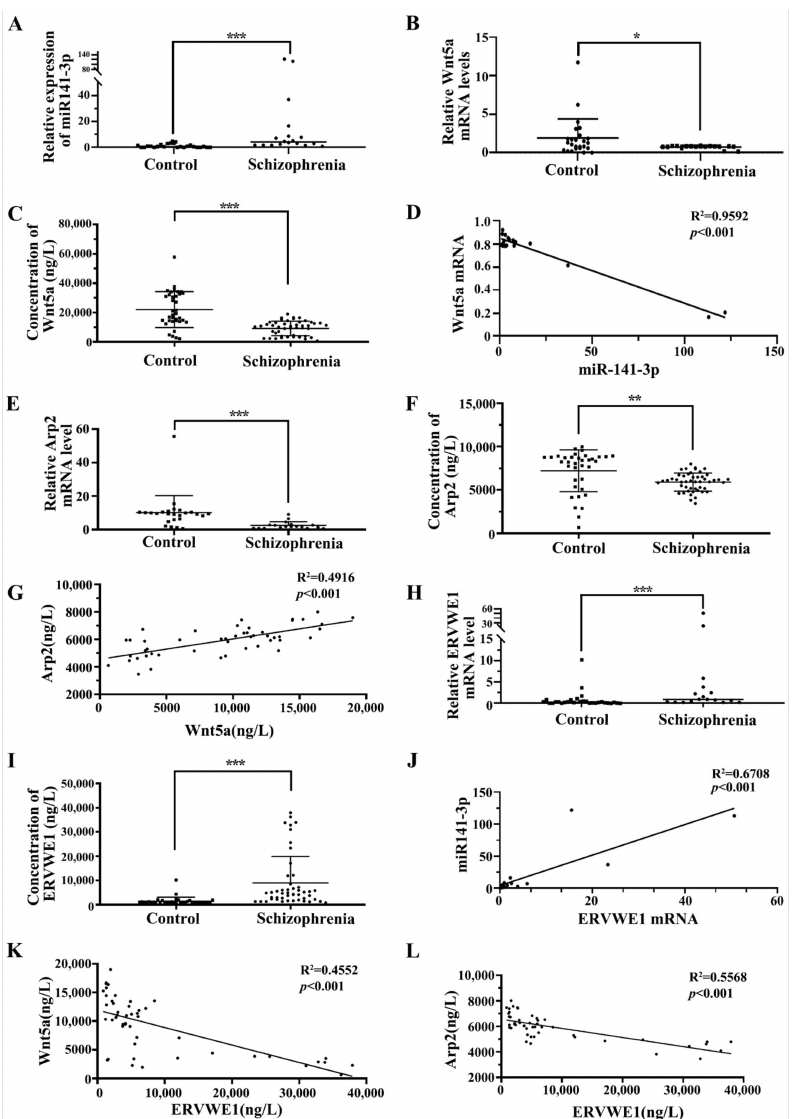
Figure 1. The correlation among miR-141-3p, Wnt5a, Arp2, and ERVWE1 in schizophrenia patients. ( A ) The miR-141-3p level in schizophrenia patients (n = 18) was higher than that in control groups (n = 25). ( B , E , H ) Respectively represent the mRNA levels of Wnt5a, Arp2, and ERVWE1 in schizophre- nia patients (n = 18) and the control groups (n = 25) using RT-qPCR. ( C , F , I ) Respectively represent the protein expression of Wnt5a, Arp2, and ERVWE1 in the schizophrenia patients (n = 48) and in the control groups (n = 36) using ELISA. ( D ) MiR-141-3p was negatively correlated with Wnt5a mRNA in patients with schizophrenia. Where X was the miR-141-3p expression value for each sample and Y was the mRNA level for Wnt5a. ( G ) Wnt5a was positively correlated with Arp2 in patients with schizophrenia. Where X was the Wnt5a protein expression level and Y was the Arp2 protein level for each sample. ( J ) ERVWE1 was positively correlated miR-141-3p in patients with schizophrenia, where X was the ERVWE1 mRNA value and Y was the miR-141-3p level for each sample. ( K ) ERVWE1 was negatively correlated with Wnt5a in schizophrenia patients, Where X was the ERVWE1 protein value and Y was the Wnt5a protein level for each sample. ( L ) ERVWE1 was negatively correlated with Arp2 in schizophrenia patients, where X was the ERVWE1 protein value and Y was the Arp2 protein expression for each sample. *** p < 0.001, ** p < 0.05, * p <